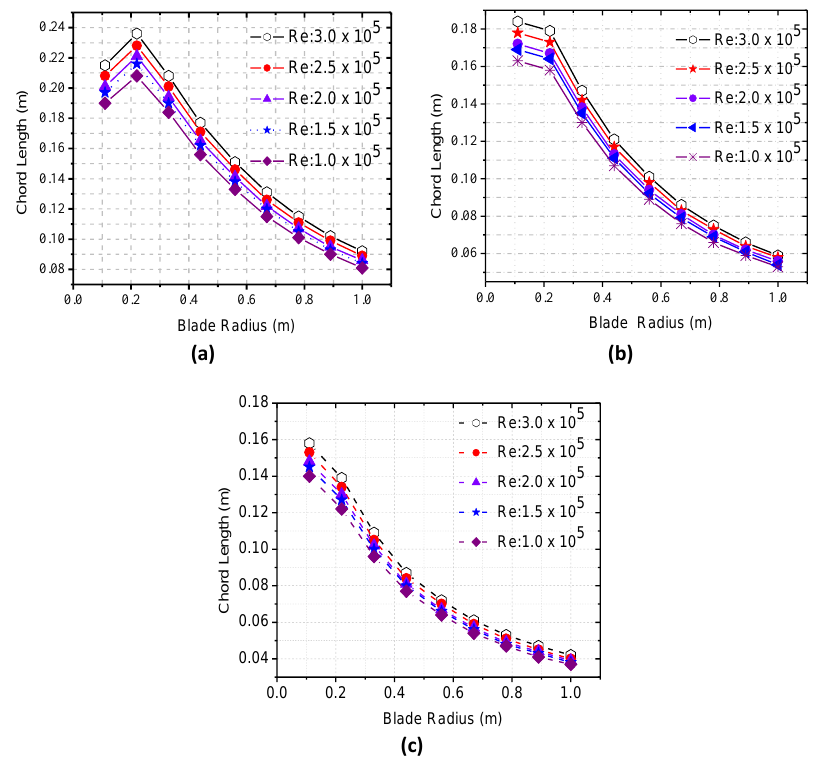
Figure 6. Blade optimum chords distribution for SG6043 airfoil at ( a ) TSR 4; ( b ) TSR 5; ( c ) TSR 6.